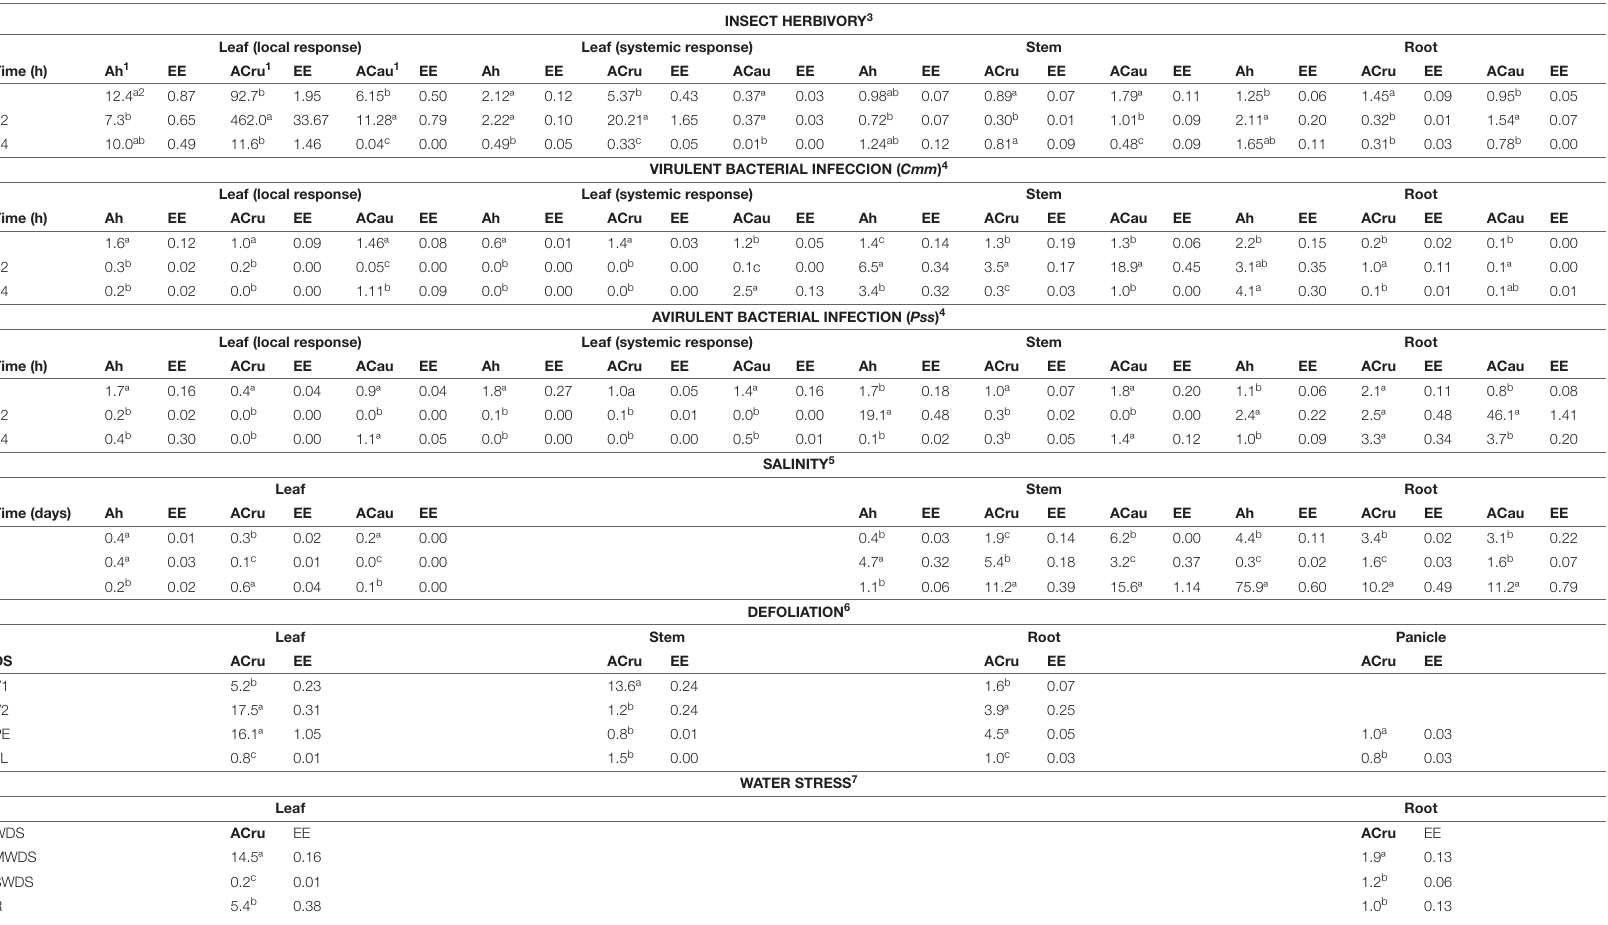
TABLE 1 | Relative expression of the AhN4L-1 gene in grain amaranths in response to (a) biotic